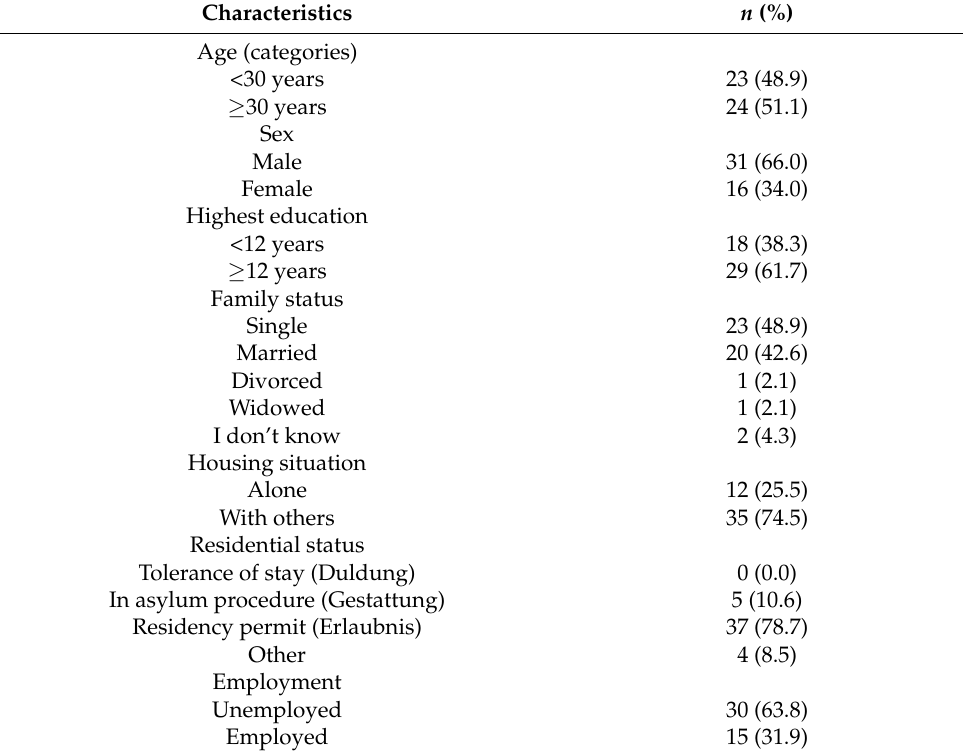
Table 2. Sociodemographic information.